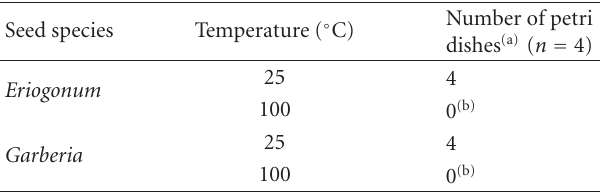
Table 8: Number (mean ± S.E.) of Eriogonum floridanum (Polygonaceae) and Garberia heterophylla (Asteraceae) seeds that germinated after being exposed to 60 ◦ C or 25 ◦ C for 30 minutes.